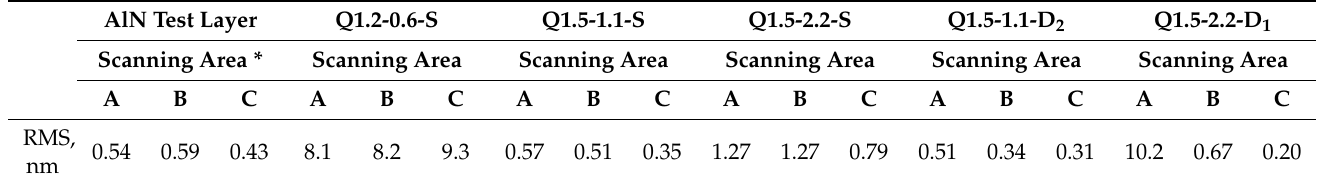
Table 1. Characteristics of surface topographies for the AlN layer and MQW